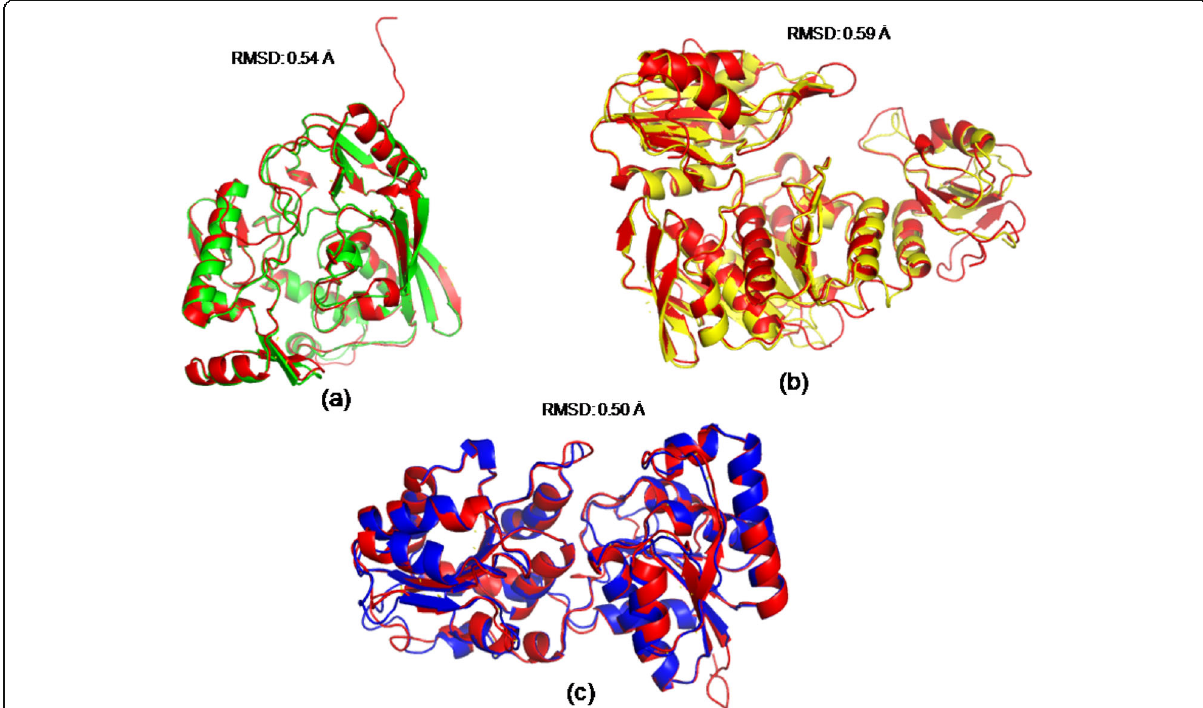
Fig. 17 Structural superimposition of a MurB from A . baumannii and A . calcoaceticus , b MurE from A . baumannii and A . seifertii , and c MurG from A